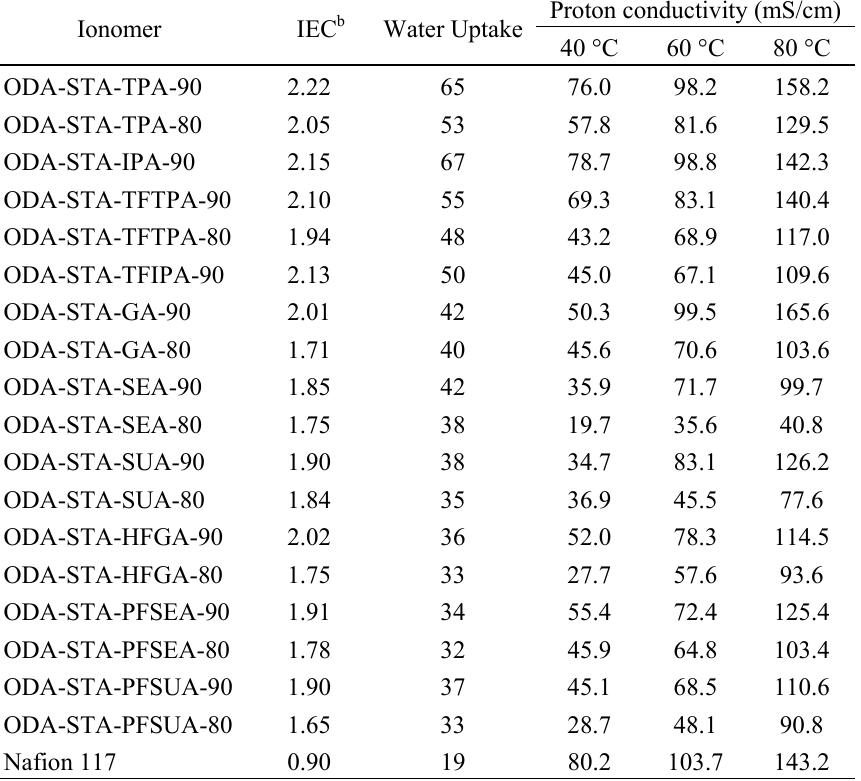
Table 3. Proton conductivity of sulfonated poly(ether amide) membranes a